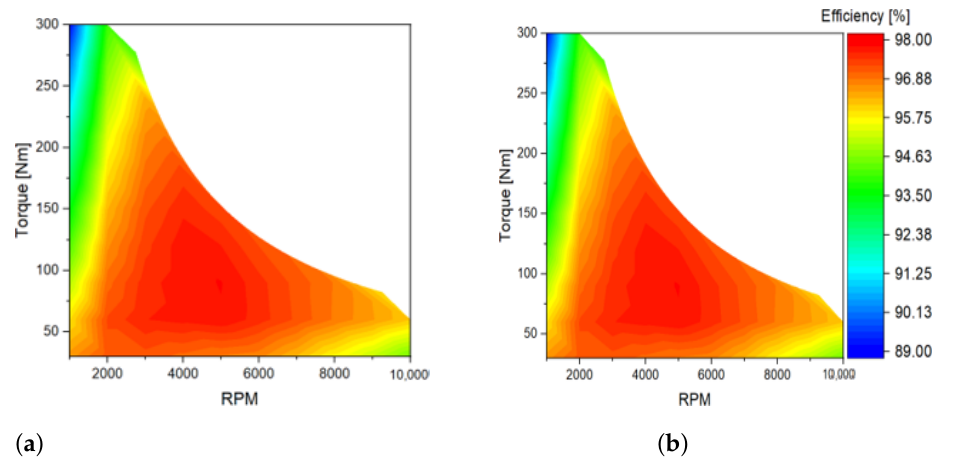
Figure 19. Efficiency maps: ( a ) conventional method. ( b ) proposed method. Table 5. Comparison of Analysis